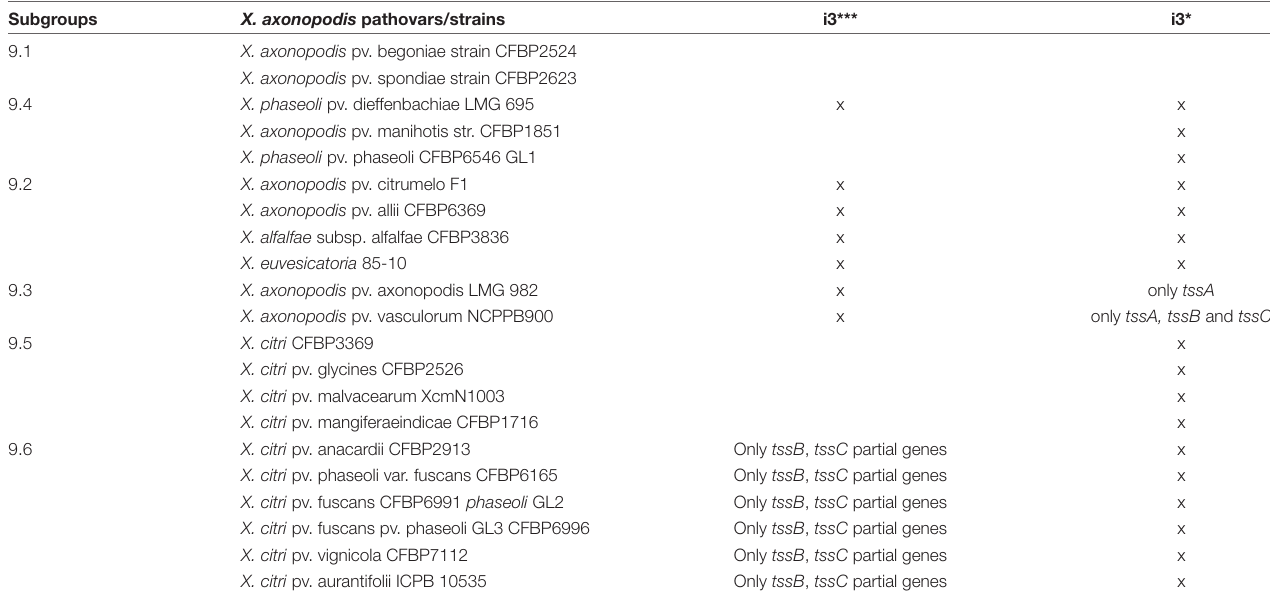
TABLE 2 | Distribution of the i3* and i3*** clusters in the X. axonopodis complex.